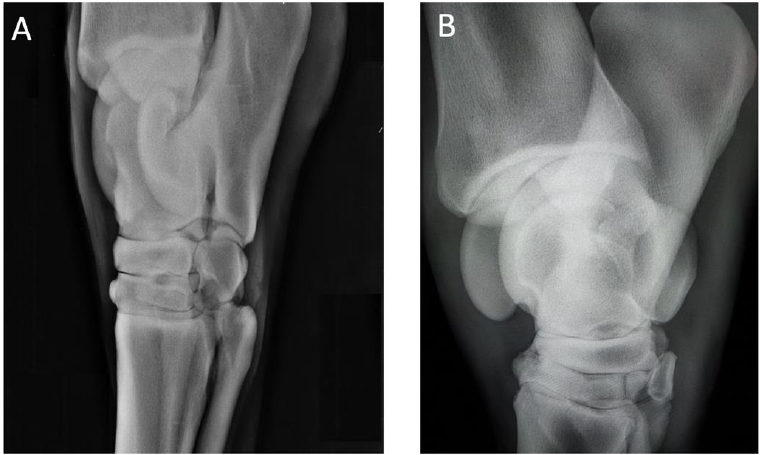
Figure 3. X-ray of the right hindlimb lateromedial. Panel ( A ): Case 3, a 14-year-old Holstein mare jumping horse. Panel ( B ): Case 4, a 15-year-old NRPS mare .